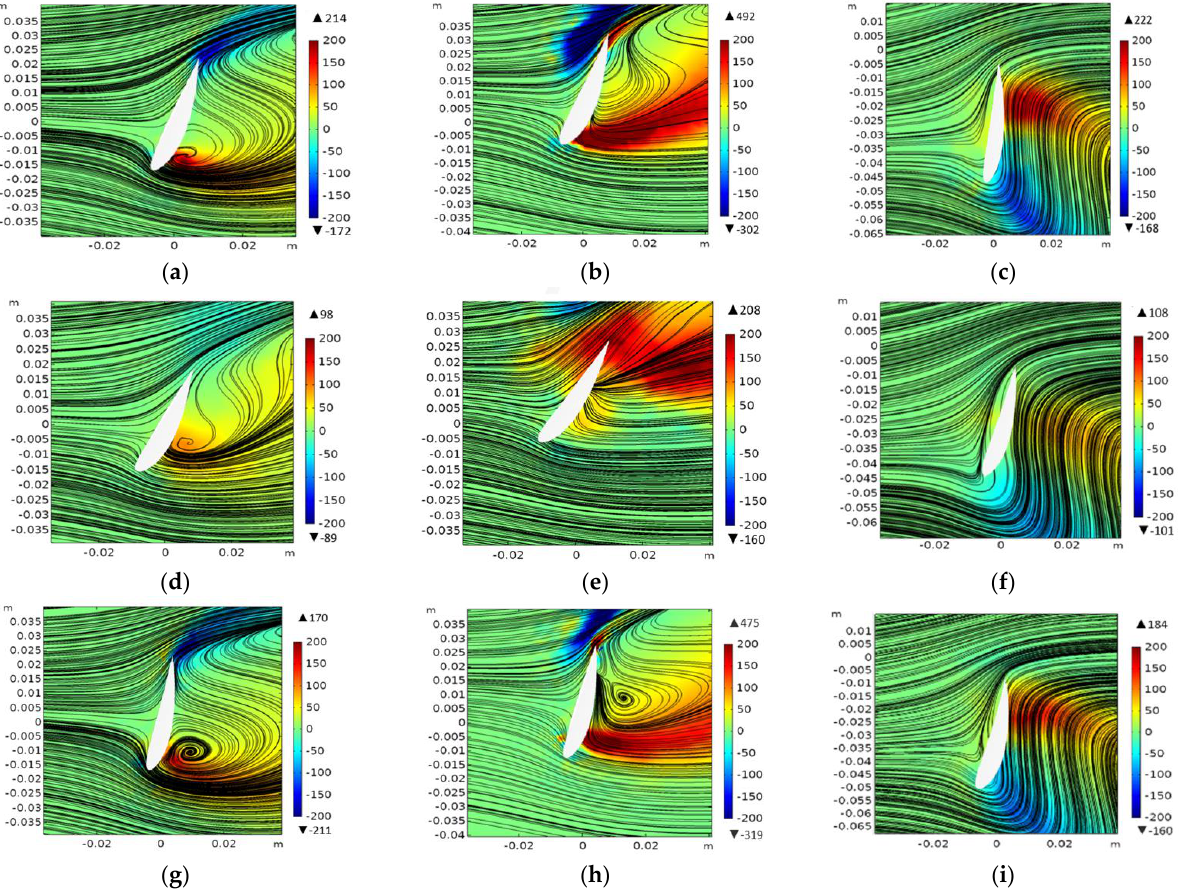
( f ) Figure 13. Velocity profiles of the flow surrounding the rotating turbine for ( a ) Fit A, ( b ) Fit B, ( c ) Fit